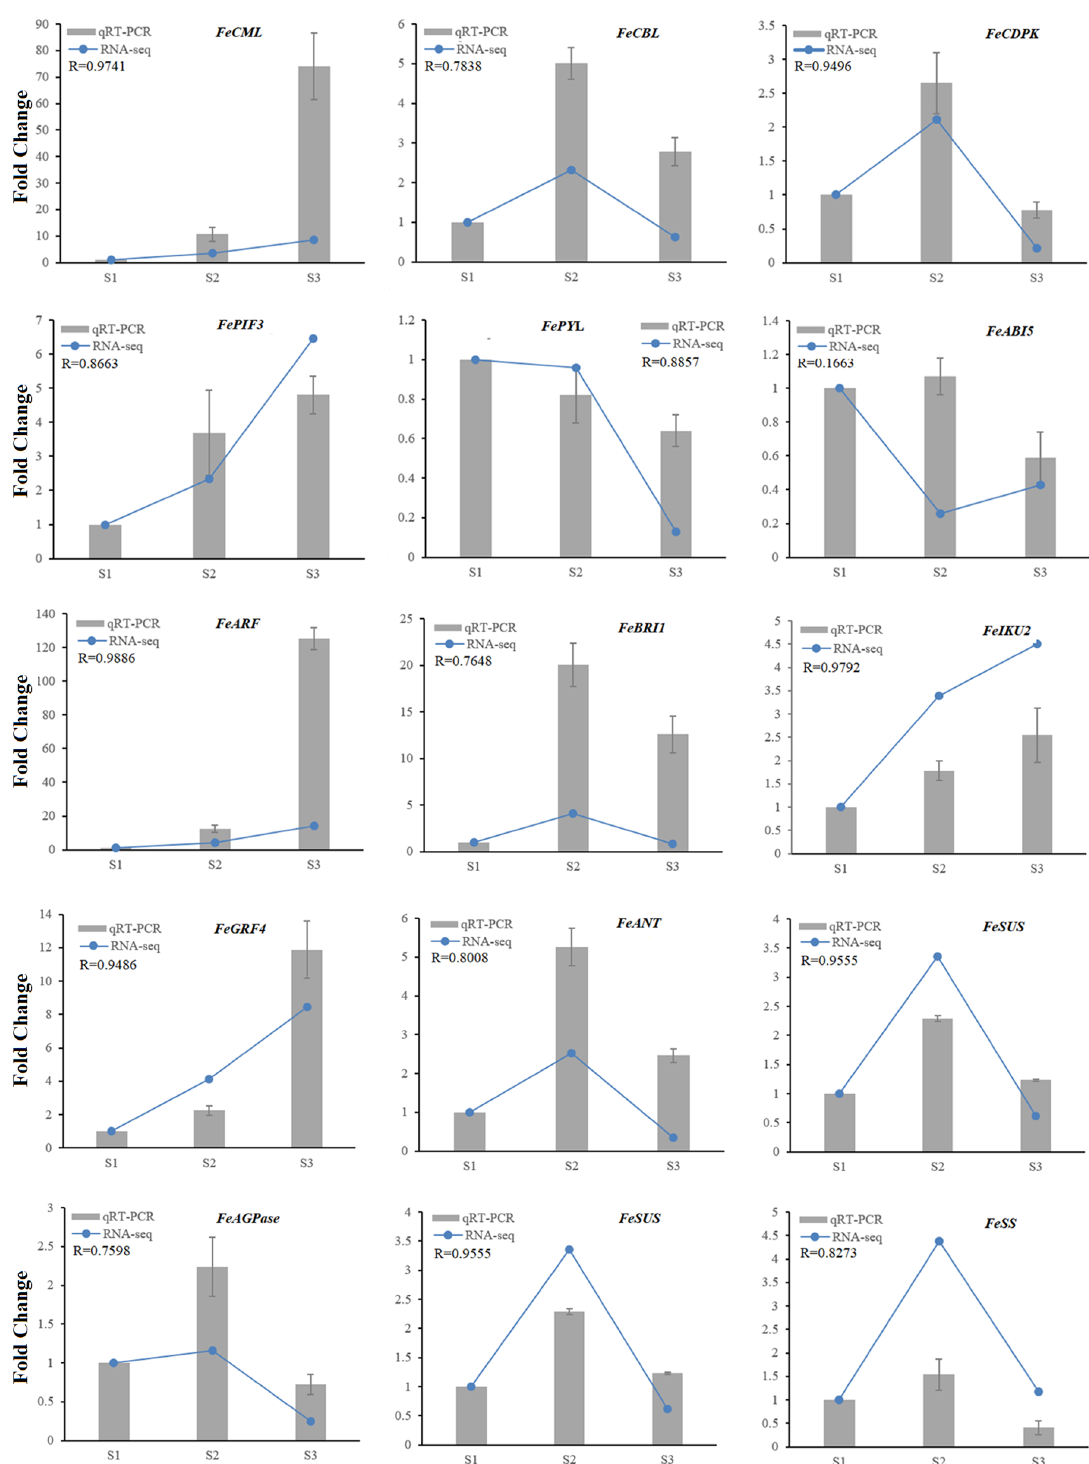
Figure 7. qRT-PCR confirmed 15 DEGs in developing common buckwheat seed. Blue lines represent the RNA-seq values of these selected genes, and grey columns indicate the qRT-PCR results. Relative expression levels of qRT-PCR were calculated using β -actin as a standard. Pearson correlation coe ffi cients were calculated by comparing qRT-PCR and RNA-Seq data for each gene across all